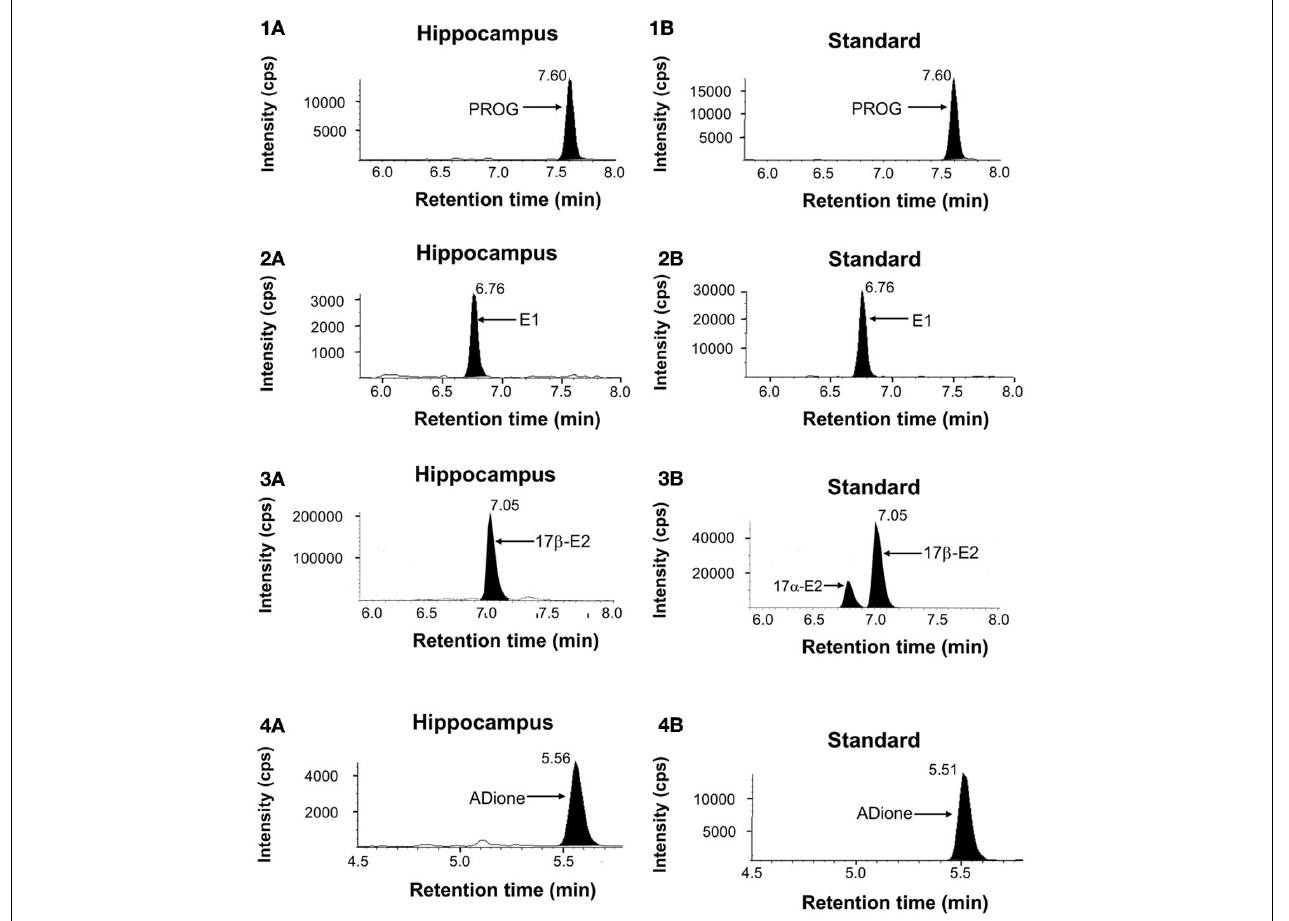
FIGURE 1 | Mass-spectrometric analysis of hippocampal sex-steroids (12-week-old rats). LC-MS/MS ion chromatograms of PROG (1), E1 (2), E2 (3), and ADione (4). (1A) , (2A) , (3A) , and (4A) represent the chromatograms of the fragmented ions of each steroid from the hippocampus. Shaded portions indicate the intensity of fragmented ions of PROG (m/z = 97), E1 (m/z = 157), E2 (m/z = 339), and ADione (m/z = 109), respectively. (1B) , (2B) , (3B) , and (4B) represent the chromatograms of the fragmented ions of the standard steroids. The vertical axis indicates the intensity of the fragmented ion. The horizontal axis indicates the